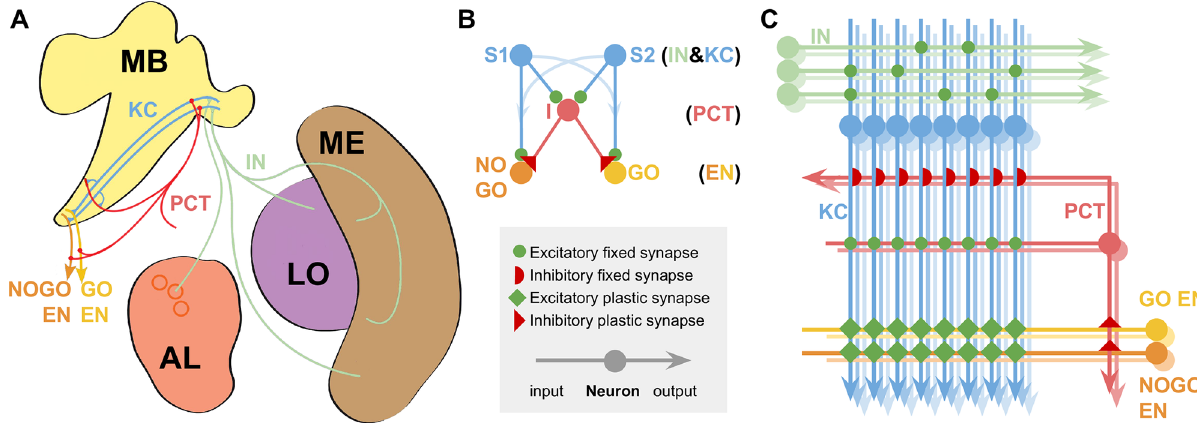
Fig 1. Models of the mushroom bodies based on known neuroanatomy. A Neuroanatomy: MB Mushroom Bodies; AL Antennal Lobe glomeruli (circles); ME & LO Medulla and Lobula optic neuropils. The relevant neural pathways are shown and labelled for comparison with the model. B Reduced model; neuron classes indicated at righthand side of sub-figure. C Full model, showing the model connectivity and indicating the approximate relative numbers of each neuron type. Colour coding and labels are preserved throughout all the diagrams for clarity. Excitatory and inhibitory connections indicated as in figure legend. Key of neuron types: KC, Kenyon Cells; PCT, Protocerebellar Tract neurons; IN, Input Neurons (olfactory or visual); EN, Extrinsic MB Neurons from the GO and NOGO subpopulations, where the subpopulation with the highest sum activity defines the behavioural choice in the experimental protocol (Fig 4).